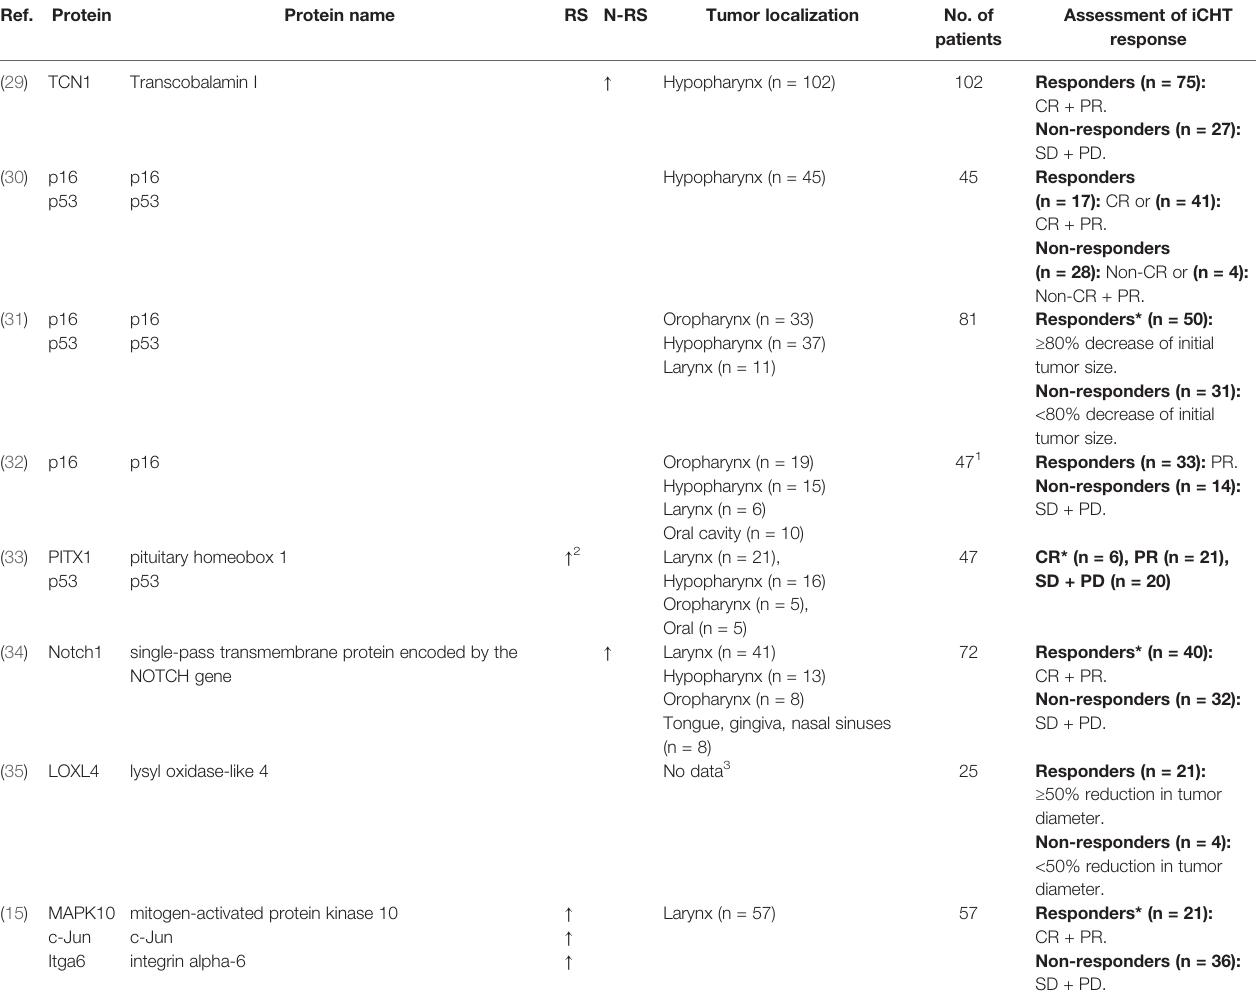
TABLE 2 | Summary of protein-based studies on predicting iCHT response. Ref.